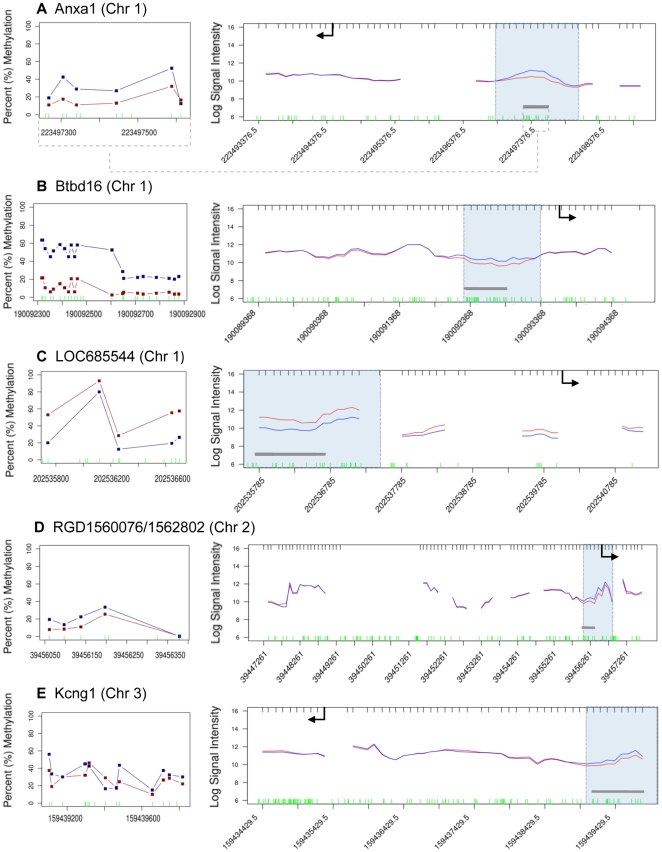
Comparison of the methylation signal in regions where transgenerational methylation change is confirmed between vinclozolin and control.Analysis of methylation through MeDIP followed by comparative hybridization is graph on right with genome location and log signal intensity presented with shaded area being the differential methylation region. Heavy red line indicates control and blue line indicates vinclozolin and arrow indicates transcriptional start site and direction. The graph on left is the bisulfite mass spectrometry analysis of CpG sites within the bar in shaded area of right graph indicated with percent methylation data presented for each gene (a-n). Horizontal axis shows chromosomal localizations. Inset legend presented in Figure 4.